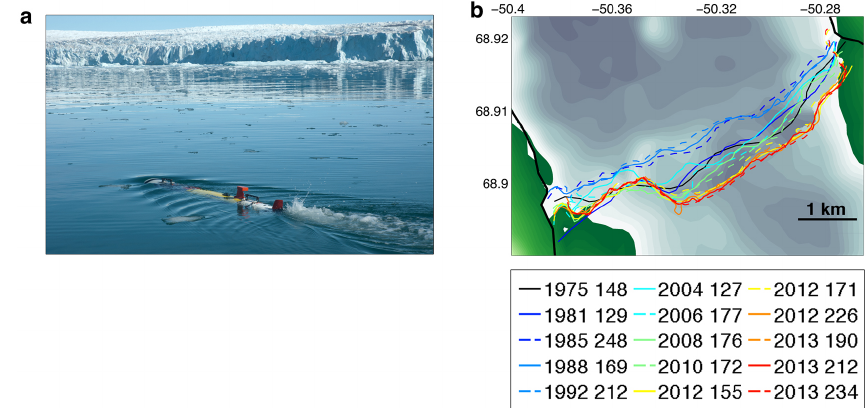
Figure 2. REMUS-100 AUV and past Saqqarliup sermia terminus positions in Sarqardleq Fjord. (a) REMUS-100 AUV before deployment in Sarqardleq Fjord. Note dense ice cover along Saqqarliup sermia terminus. (b) Saqqarliup sermia terminus 1975–2013 summertime posi- tions digitized from the Landsat archive (http://earthexplorer.usgs.gov/) over fjord bathymetry and subglacial topography (see Fig. 3). Front position dates are listed in the legend as year and day of